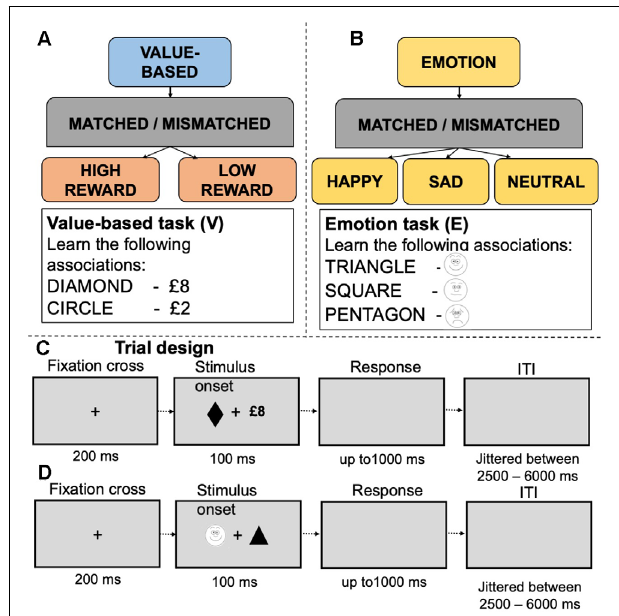
FIGURE 1 | Experimental design and examples of stimuli in the value-based (A) and emotion (B) tasks. Panels (C,D) depict experimental trials for the value-based and emotion tasks